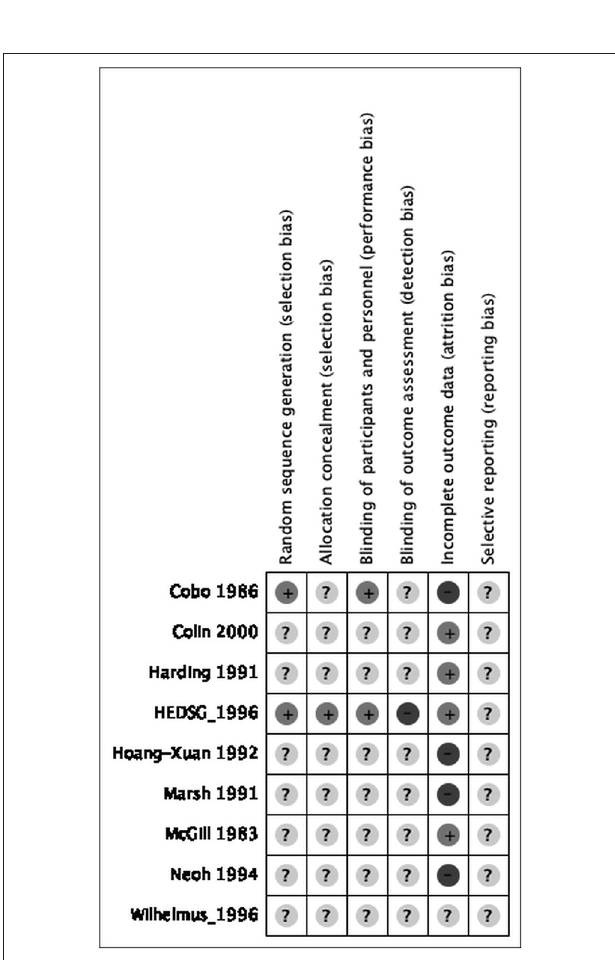
FIGURE 3 | Risk of bias summary: review authors’ judgements about each “Risk of bias” item for each included